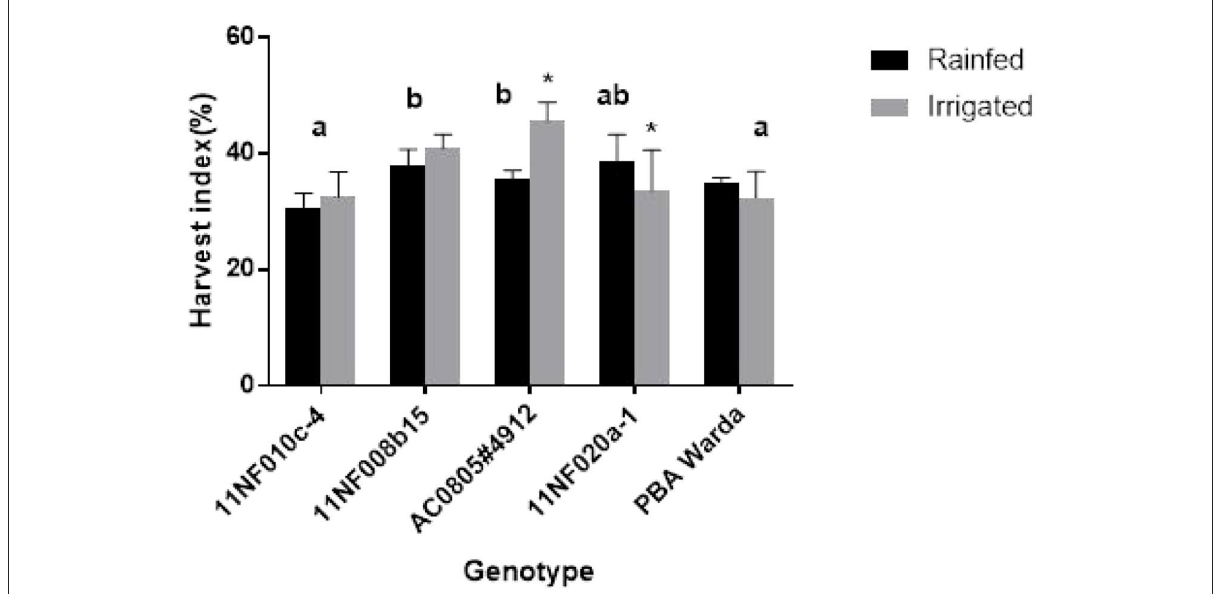
FIGURE5 Harvest index (HI) (%) of contrasting faba bean genotypes grown under field condition (irrigated and rainfed trial) at Narrabri, Australia. Error bars were calculated from four replicates and represent standard error of the mean. Different letters represent a significant difference ( p < 0.05) among genotypes calculated through DMRT. Asterisks (*) represent significance between irrigated and rainfed treatments.